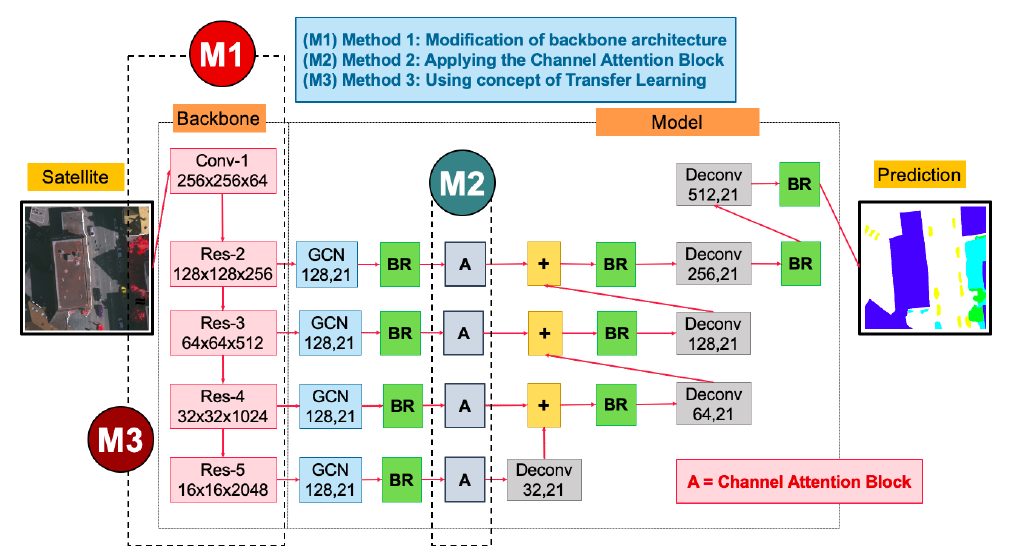
Figure 1. An overview of enhanced GCN (Global Convolution Network [11]) with transfer learning and attention mechanism (GCN152-TL-A) [12].